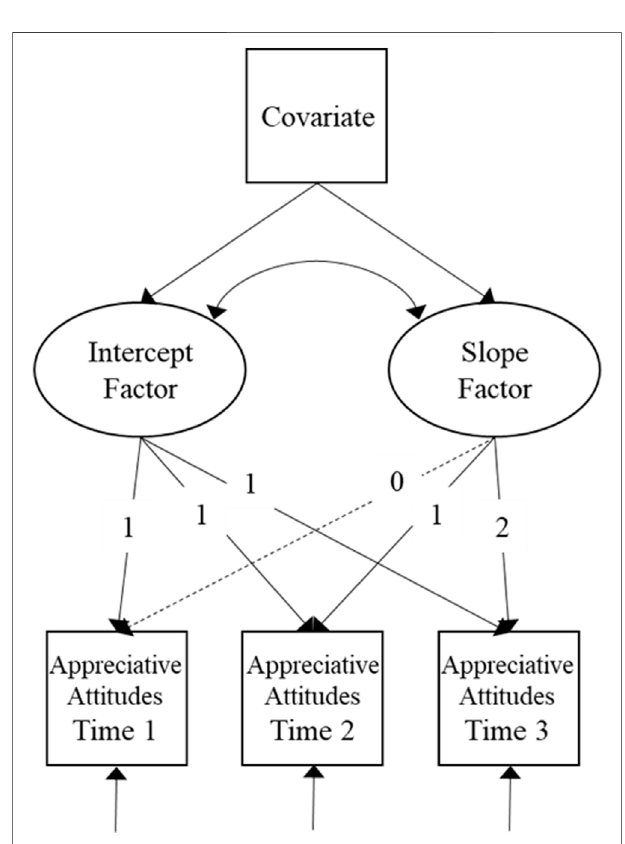
FIGURE 2 | Latent growth model for appreciative attitudes toward evangelical